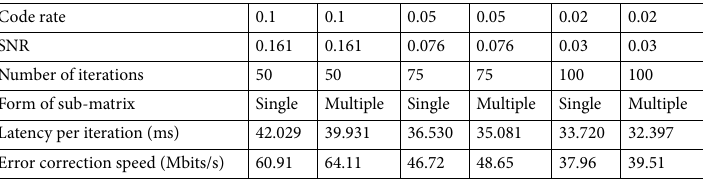
Table 1. Performance comparison of the layered BP decoder when decoding different forms of